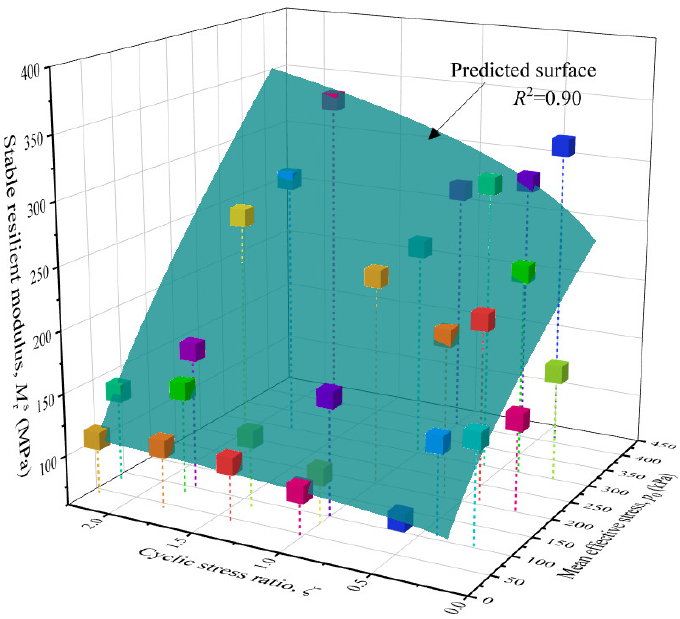
Figure 13. Predicted surface of stable resilient modulus calculated from Equation (15).